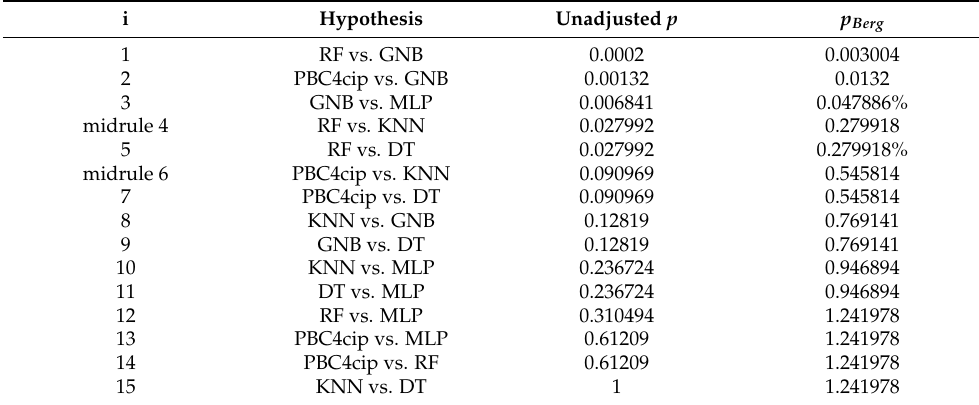
Table 9. Unadjusted and Adjusted p -value for the post-hoc analysis